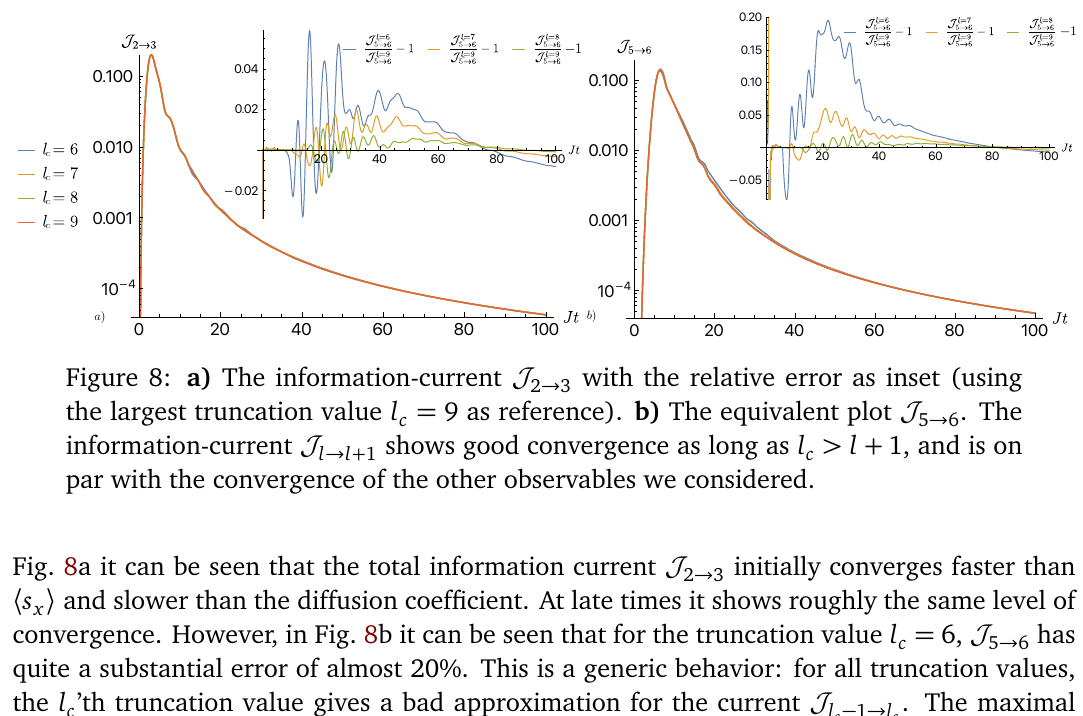
→ 6 . The J 5 > l + 1, and is on